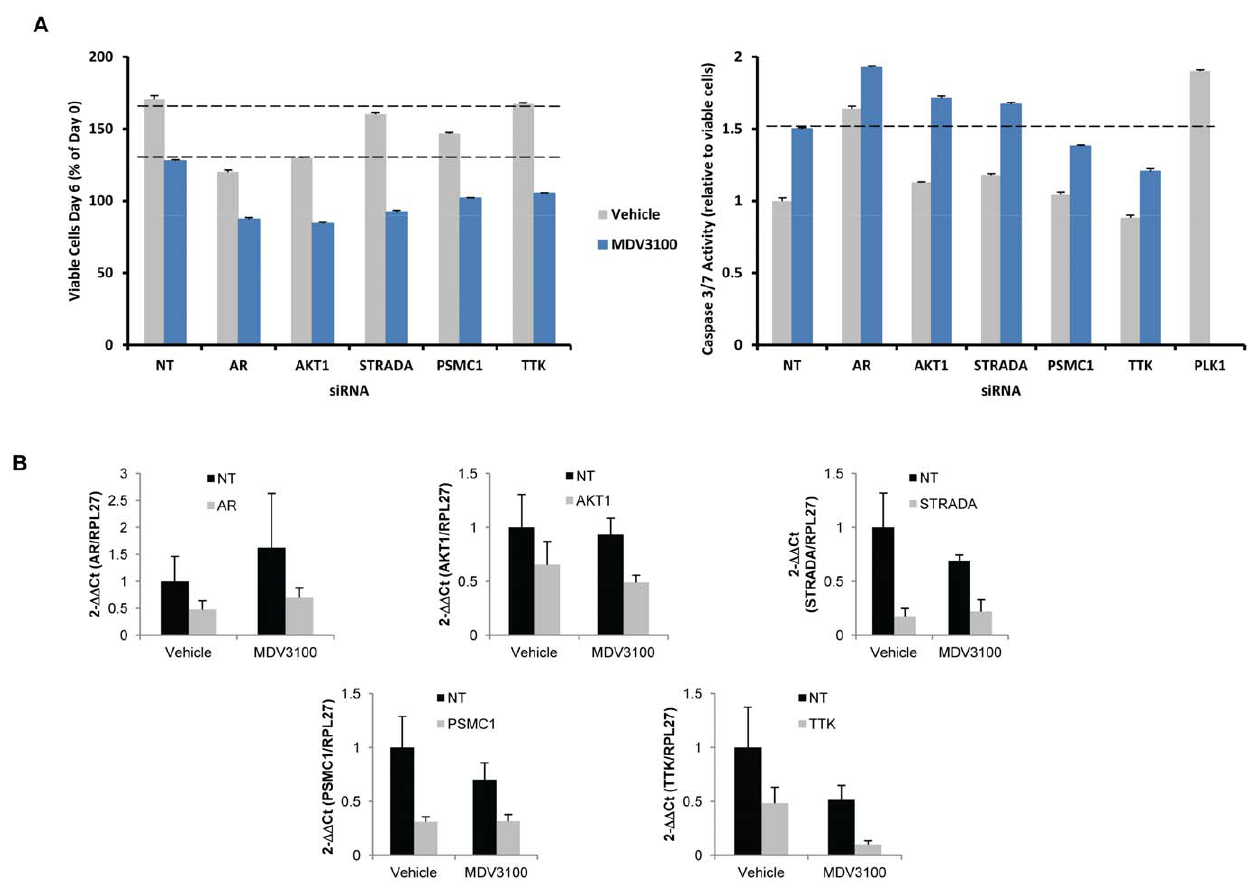
Figure 2. Silencing of a subset of genes inhibited VCaP proliferation and induced apoptosis. Candidate target genes from LNCaP screen probes that were depleted in the presence of bicalutamide were selectively targeted using siRNAs. (A, left panel), VCaP cells were transfected with siRNAs that scored in the LNCaP drug screen and were incubated with 1 uM MDV3100 or vehicle, and the number of viable cells was measured 6 days post-treatment. (A, right panel), VCaP cells were transfected and treated as in (A, left panel) except Caspase 3/7 activity was measured after 3 days of treatment. PLK1 siRNA transfection was used as a positive control. Dashed lines indicate the level of growth inhibition or apoptosis induced by MDV3100, for comparison. NT, non-targeting siRNA. (B) Gene silencing (10–50%) was confirmed by RT-qPCR 6 days post-transfection of VCaP cells with the siRNA SMARTpools. Reactions were done in triplicate and normalized to RPL27 for each cDNA and then normalized to vehicle-treated NT. Standard error of the mean was calculated. Bic,